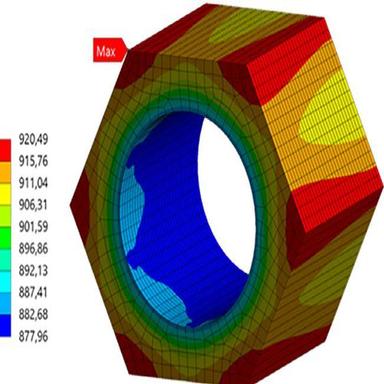
Temperature distribution within hexagonal TiBe12 block at the end of a plasma pulse.